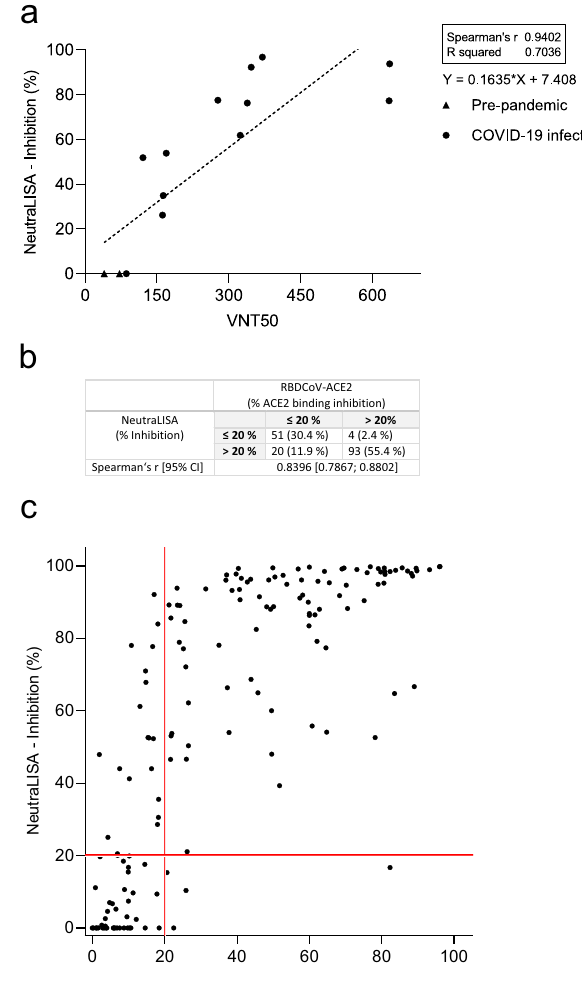
Figure 2. Correlation between SARS-CoV-2 NeutraLISA and VNT and comparison to RBDCoV-ACE2. ( a ) Correlation and linear regression between NeutraLISA and VNT results for pre-pandemic (n = 4) and COVID-19 infected (n = 12) samples. Correlation analyses were performed after Spearman and correlation coefficients r are shown. ( b ) Descriptive statistics of the ( c ) correlation between NeutraLISA and RBDCoV- ACE2. One sample from each individual (n = 168) was measured using both assays. Correlation was calculated after Spearman. Samples were classified as being negative (non-neutralizing) if they had a value below 20% (red